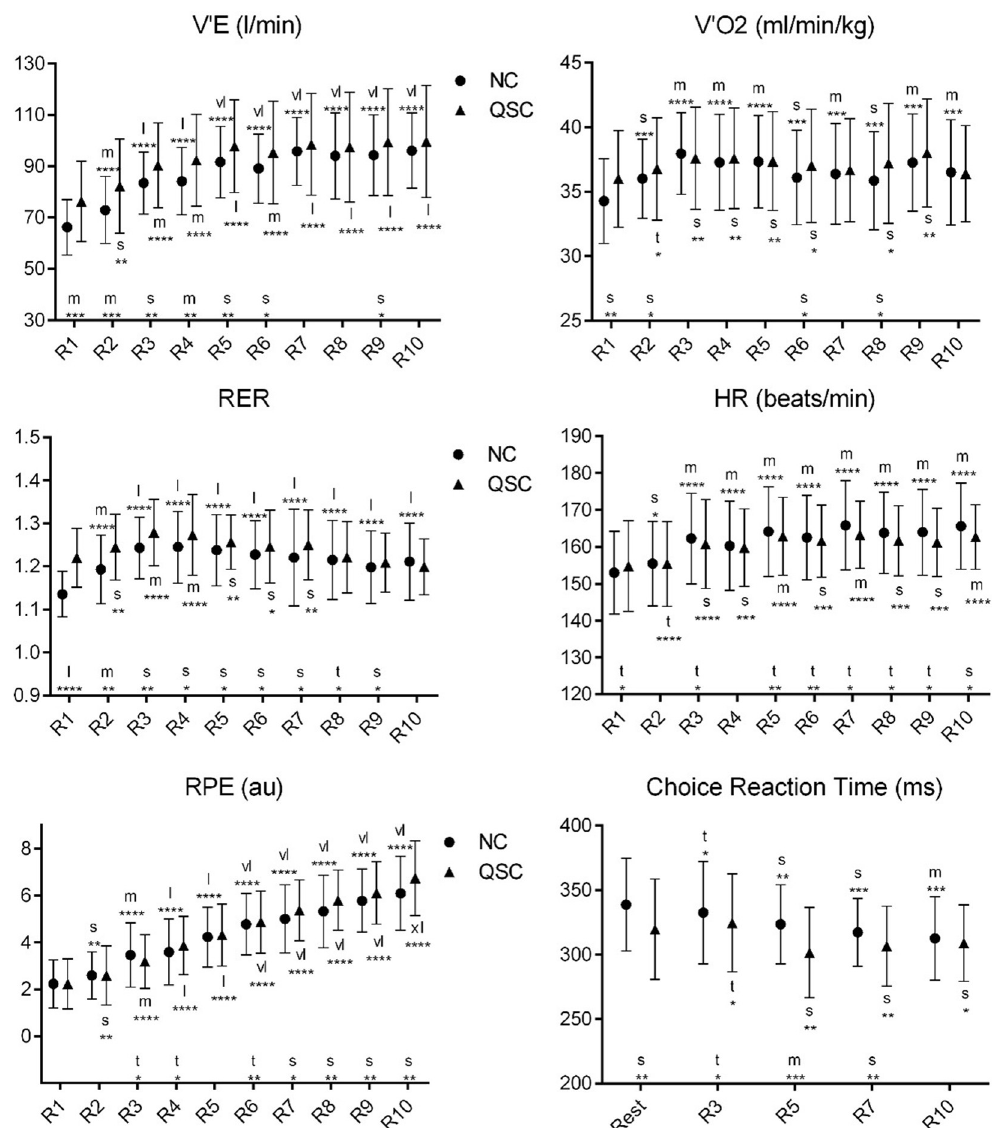
Fig 2. Change in the means of physiological and psychomotor variables in each repetition in NC and QSC. Error bars are 90% compatibility intervals. Letters stand for the magnitude of the mean changes as following: t = trivial; s = small; m = moderate; l = large; vl = very large; xl = extremely large. Asterisks indicate the likelihood for the magnitude of the true effect as follows: � possible; �� likely; ��� very likely; ���� most likely. Letters and asterisks next to the x-axis indicate the magnitude and uncertainty of the mean changes from the NC to QSC. Letters and asterisks above and below the error bars indicate the magnitude and uncertainty of the mean changes from the 1st repetition (or rest status) to the 2nd to 10th repetition in NC and QSC. Effects are unclear in the situations without letters or